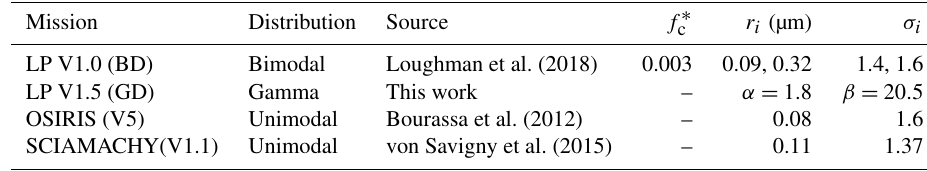
Table 1. Size distributions used in several recent limb scattering aerosol extinction retrieval algorithms. Mission